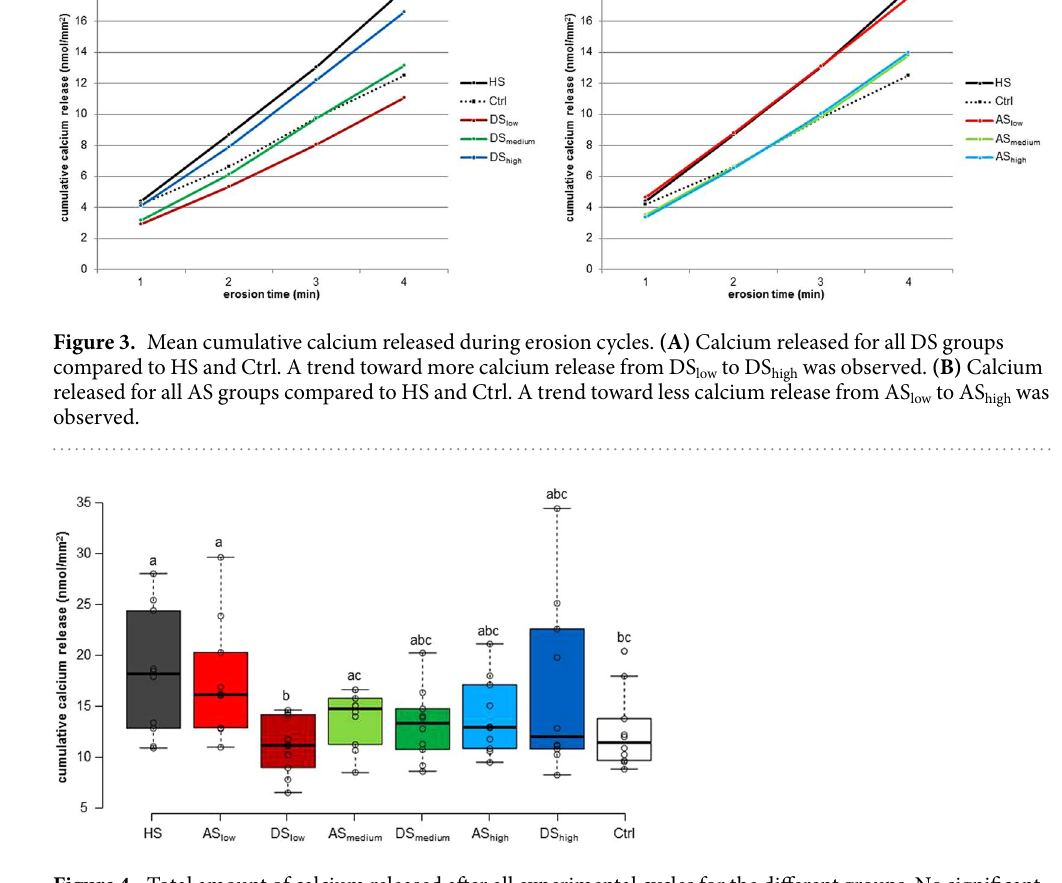
Figure 4. Total amount of calcium released after all experimental cycles for the different groups. No significant differences were observed within the DS and the AS groups. Different letters indicate significant differences between the groups (Wilcoxon-Mann-Whitney test, p <